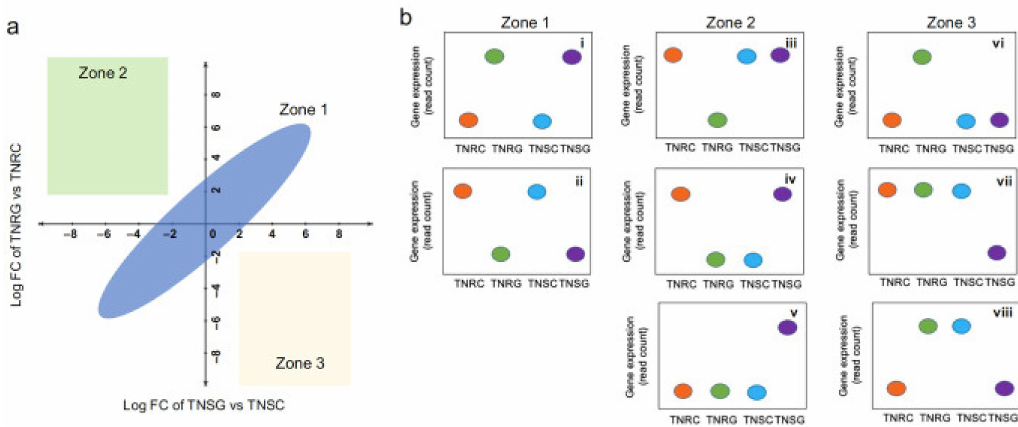
Figure 2. Correlation pattern of DEG in TNRG vs. TNRC, and TNSG vs. TNSC: ( a ) The sorted zone of correlation patterns between TNRG vs. TNRC, and TNSG vs. TNSC. Three zones can be sorted based on FC variation between two DEG analyses; ( b ) Differentially expressed mode summary depending on various read count distributions in TNR and TNS in response to